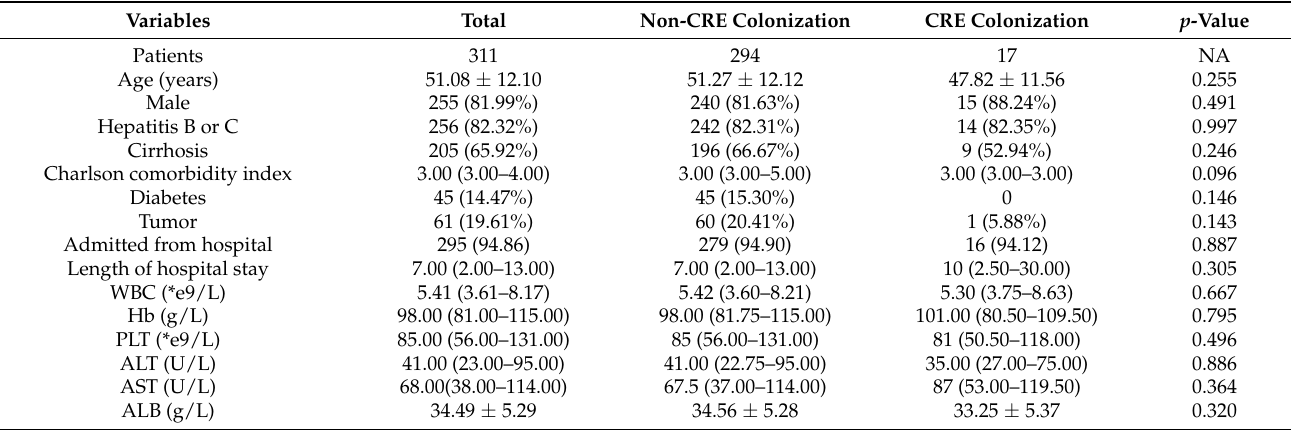
Table 1. Demographic and clinical characteristics of CRE colonization and non-CRE colonization patients with